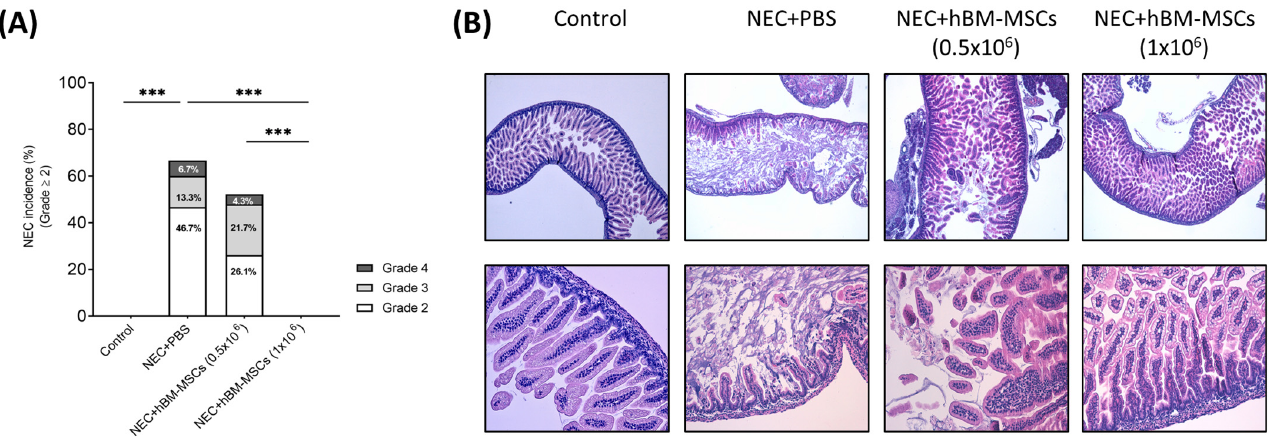
Figure 4. hBM ‐ MSCs reduced NEC incidence and severity in a concentration ‐ dependent manner